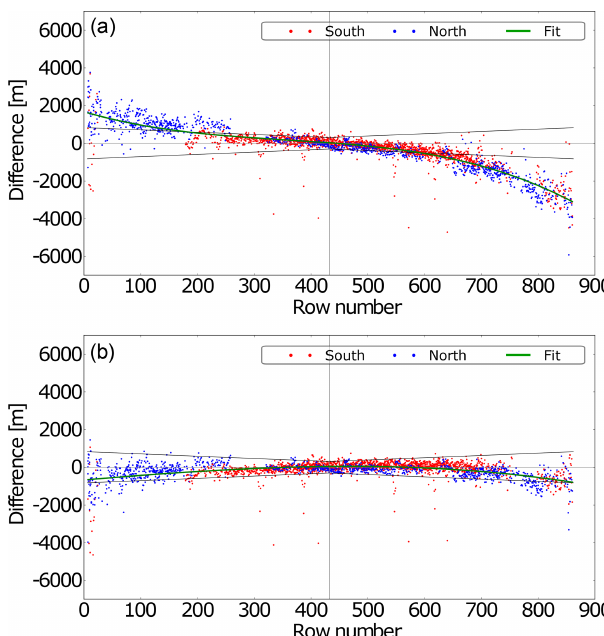
Figure 6. (a) Along-track distance between the coastline points de- termined from TROPOMI (band 6) radiance and the 50m accu- racy PGSD reference versus illuminated detector row number. The land–water orientation of the scenes are labelled by colour, while the black lines indicate the geolocation knowledge requirements, as extended linearly from the nadir to the edge of the swath. Ignor- ing outliers, at nadir (indicated by a vertical line) the differences lie within the requirement. However, large positive differences for low row numbers and large negative differences for high row numbers are distributed linearly. (b) The same data but now with a yaw-angle correction of 0.002rad applied in the L1b processor. The differences for low and high row numbers are now mostly within the require- ments (black lines) and more symmetrical.